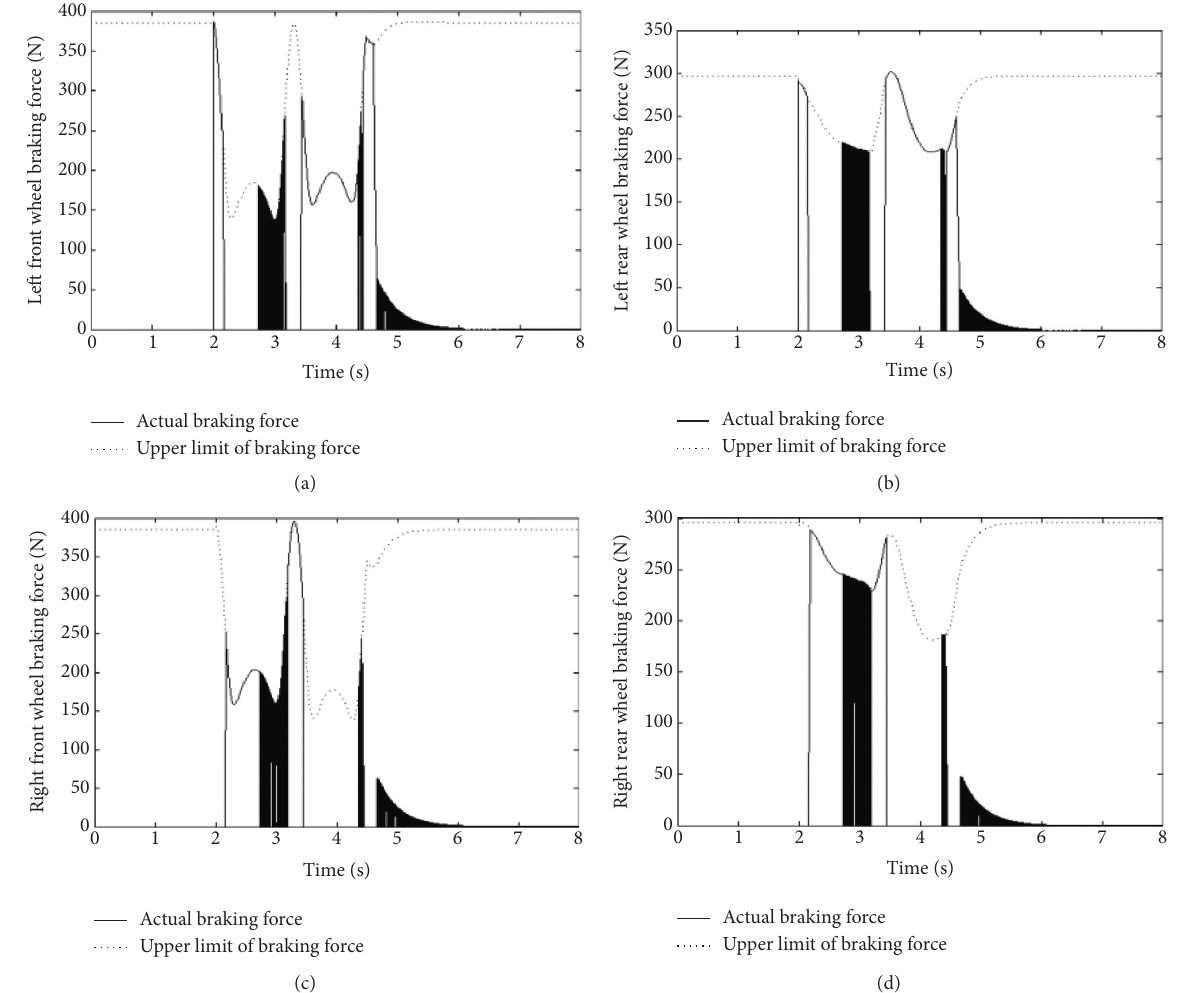
Figure 8: The braking force of each wheel applied by the controller in the state of 50 km/h single lane change. (a) Left front wheel braking force. (b) Left rear wheel braking force. (c) Right front wheel braking force. (d) Right rear wheel braking